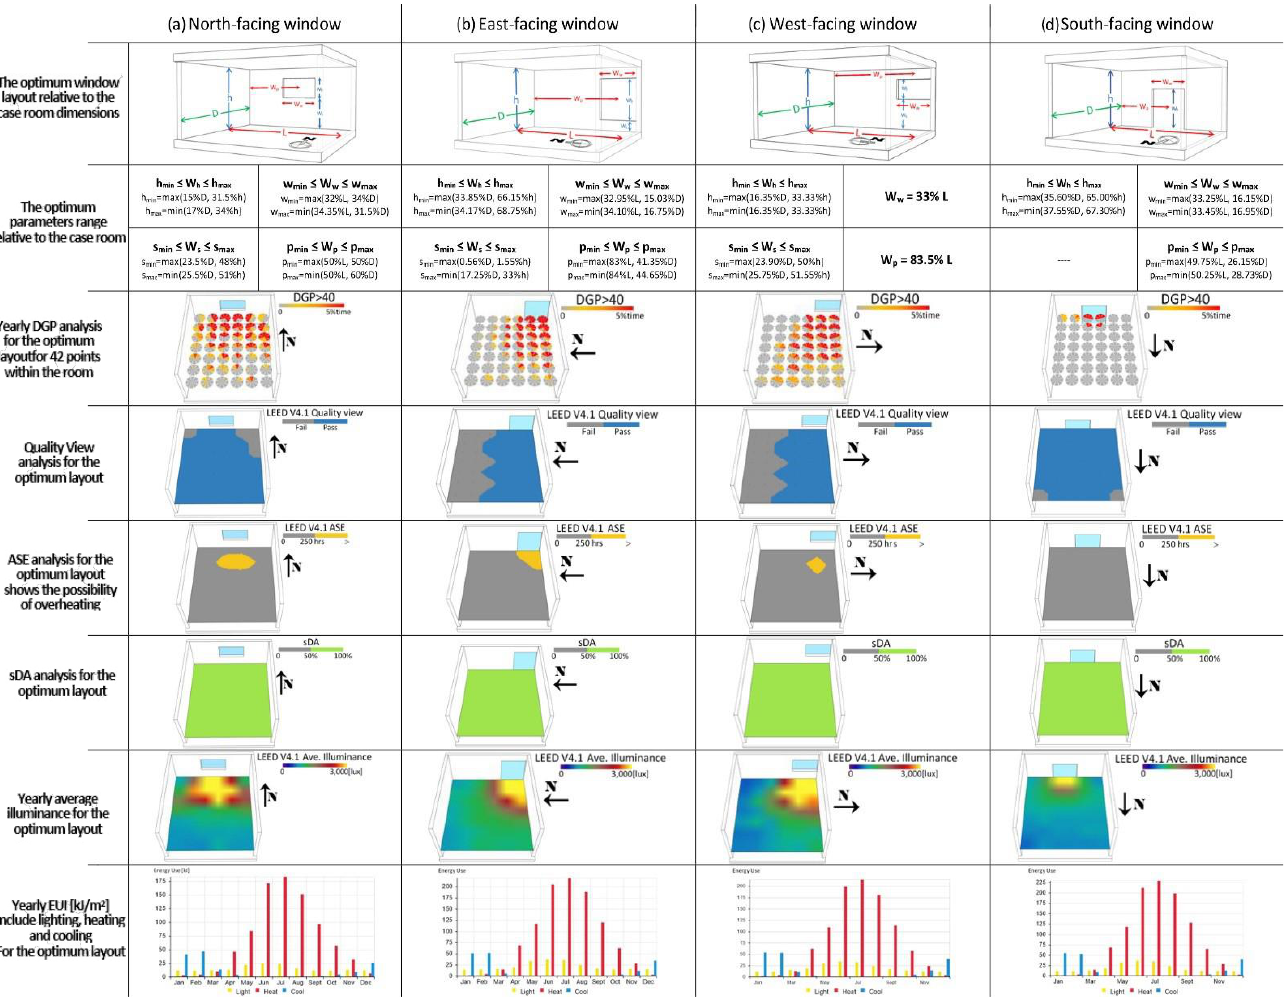
Figure 9. Optimum layouts range relative to the case room dimensions and the metrics analysis for the optimized layout for: ( a ) north; ( b ) east; ( c ) west; and ( d ) south-facing windows.